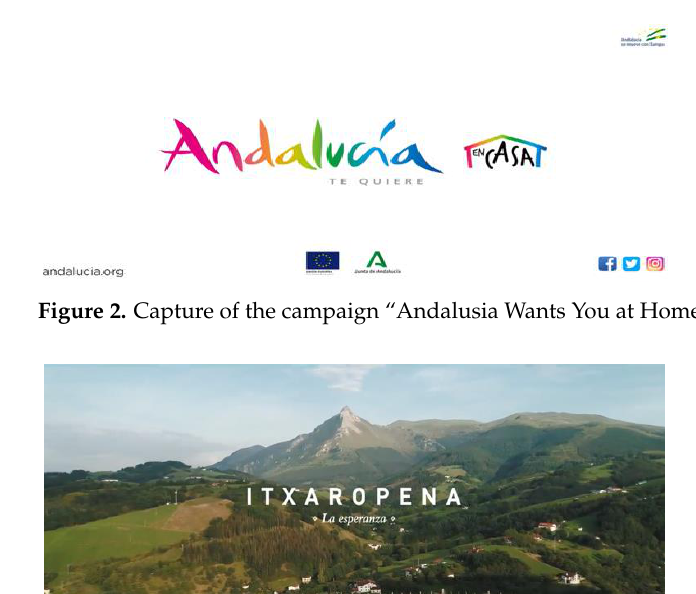
Figure 1. Capture of the campaign “Spain Awaits You”.